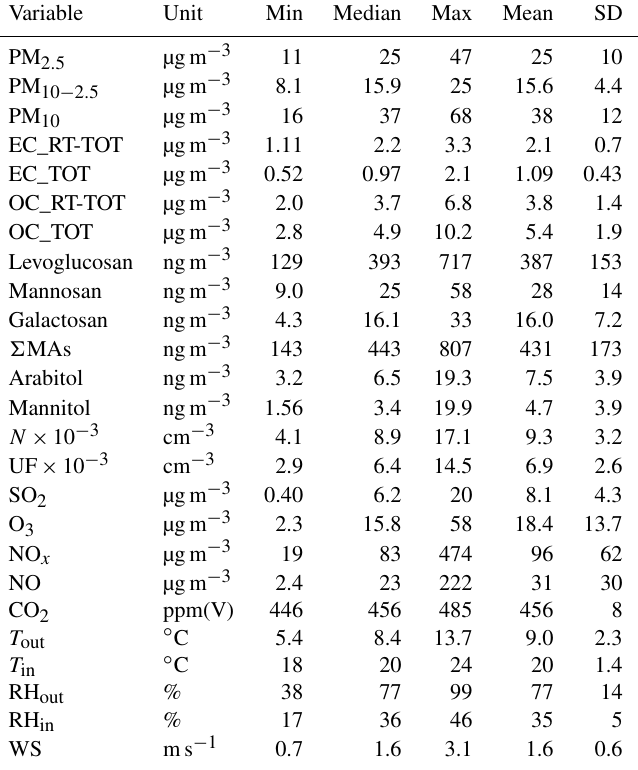
Table 1. Range, median and mean with SD of atmospheric concentrations for PM 2 . 5 mass obtained by FDMS-TEOM; PM 10 − 2 . 5 mass obtained from the SFU sampler; PM 10 mass as the sum of the previous two on a sample-by-sample basis; EC and OC measured by RT-OC/EC TOT analyser (EC_RT-TOT and OC_RT-TOT, respectively) and laboratory OC / EC TOT method (EC_TOT and OC_TOT, respectively); levoglucosan; mannosan; galactosan; sum of the three monosaccharide anhydrides ( (cid:54) MAs); arabitol; mannitol; total aerosol particle number concentration ( N) ; ultrafine particle number concentration (UF); SO 2 , O 3 , NO x , NO and CO 2 concentrations; and air temperature and RH outside ( T out , RH out , respectively) and inside ( T in , RH in , respectively) the BpART research facility; and wind speed (WS). Averaging of the online data was performed for the sample collection time periods of the SFU